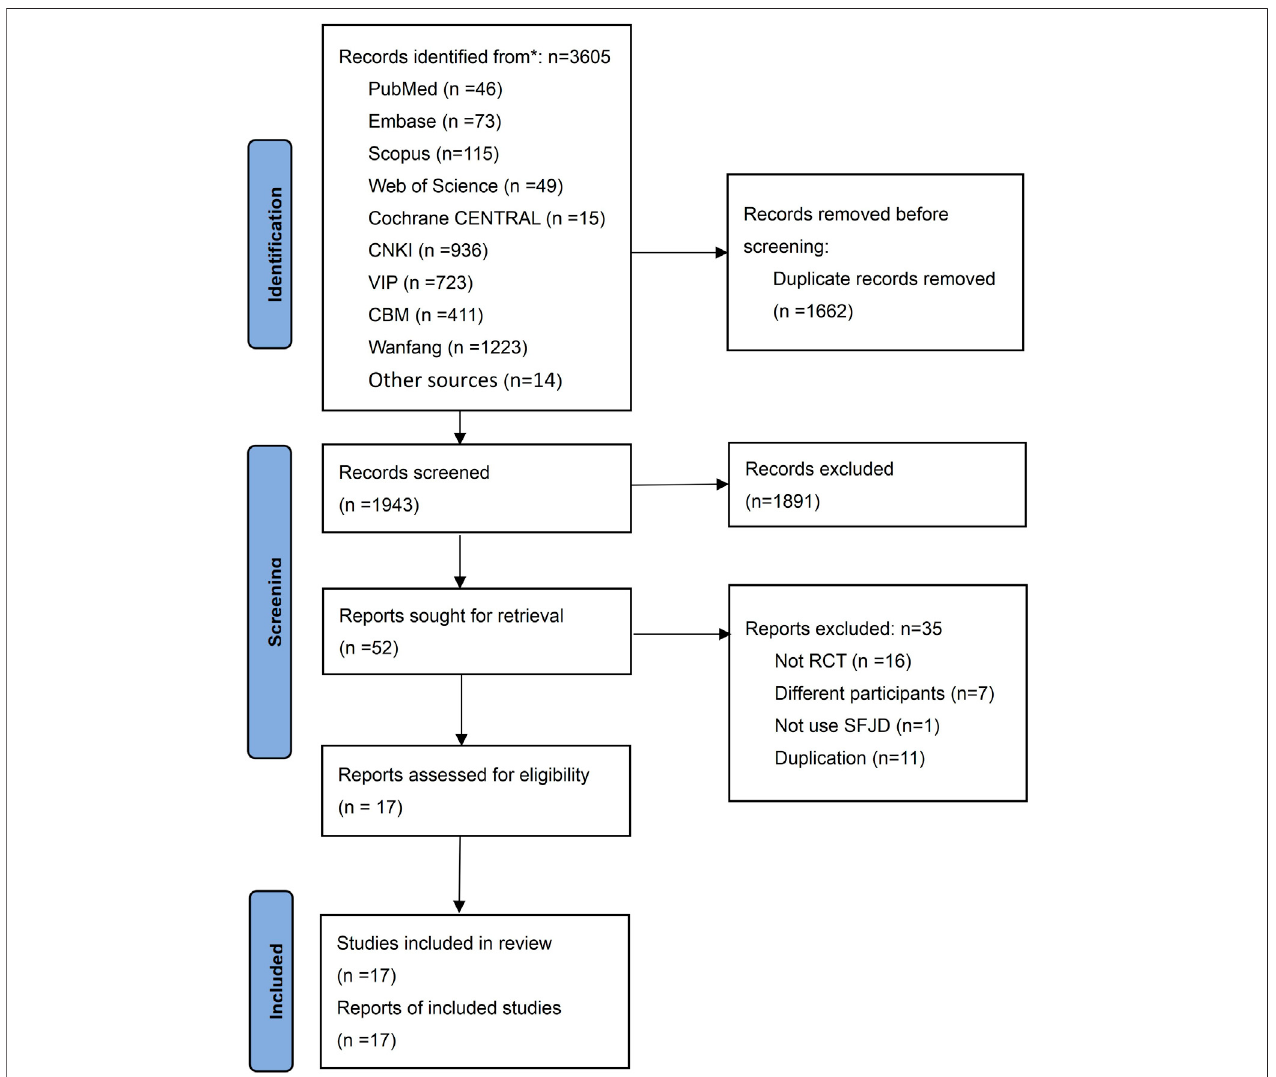
FIGURE 1 | PRISMA fl ow chart of literature searching and